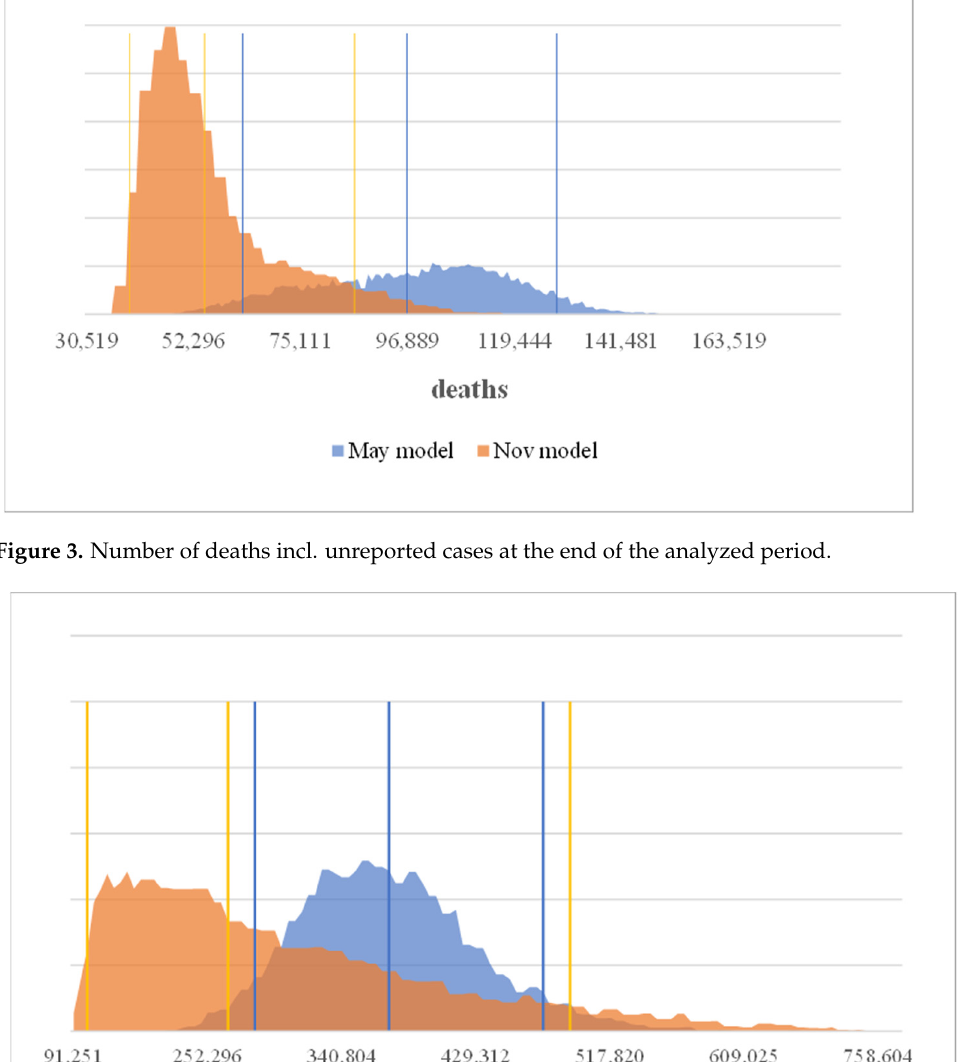
Figure 5. Saved life years incl. unreported cases at the end of the analyzed period. These years of life are offset by the net costs incurred. Thus, the (uncertain) costs per saved year of life can be determined. These are, in the May model, on average 753,900 (best and worst case 406,800 and 1,224,000). In the Nov. model, in contrast to lower net costs—based on the change in reactive policy, however, the number of deaths is also lower. Thus, the (uncertain) costs per year of life saved are 325,000 on average (with best and worst case 94,500 and 806,000), significantly lower than in the May model but change less strongly than first assumed. In the May model, there is virtually no possibility for the net costs per saved life to be under the mentioned 170,000, which studies have identified as the value of a year of life in Germany. However, in the Nov. model in about 30% of the cases this value falls below this threshold (Figure 6).